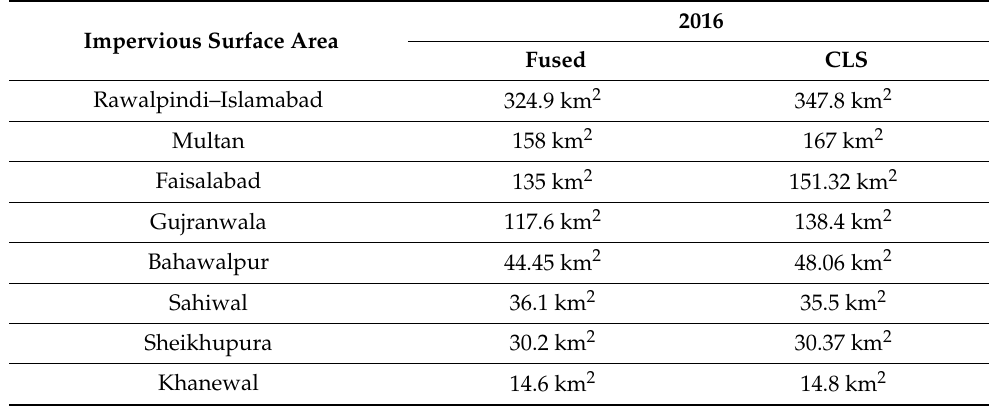
Table 8. Comparison of 2016 Impervious surface areas of cities from fused and global